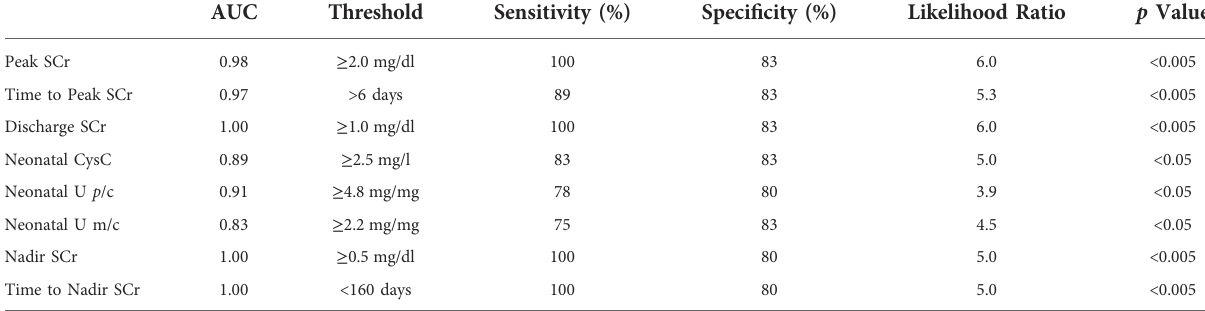
TABLE 4 Receiver operating curve (ROC) & area under the curve (AUC) analyses for biochemical predictors of CKD 4-5 in the fi rst year of life.